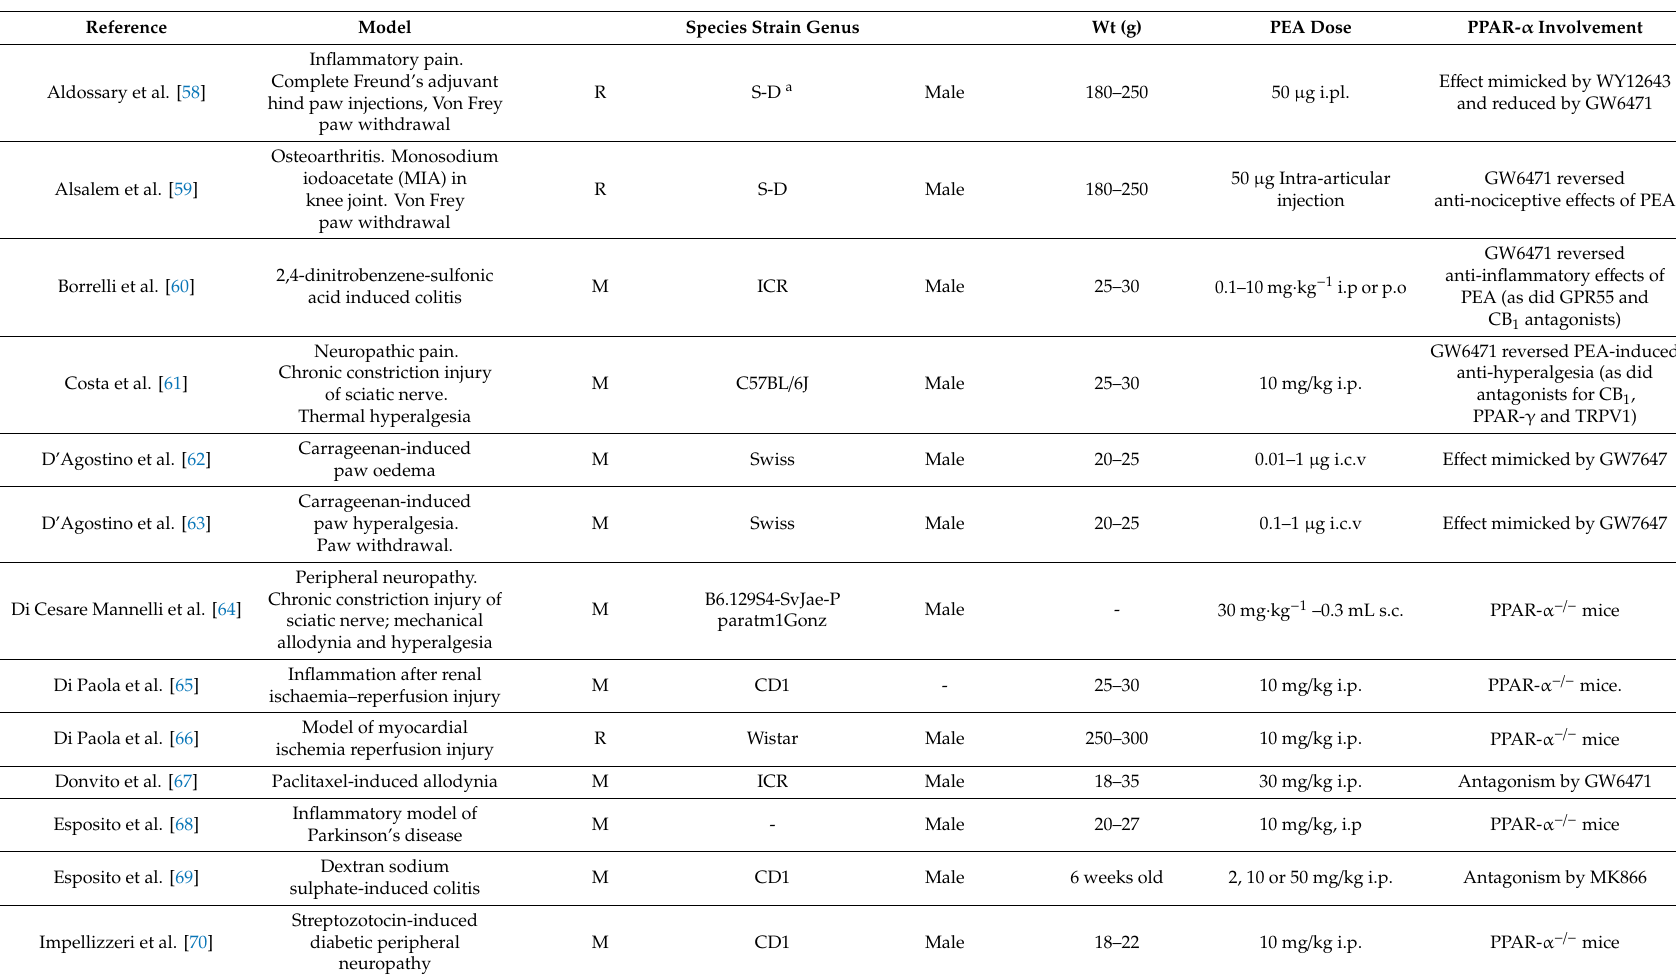
Table 1. E ff ects of palmitoylethanolamide (PEA) in relation to peroxisome proliferator-activated receptor- α (PPAR- α ) involvement in vivo (R = rat, M =